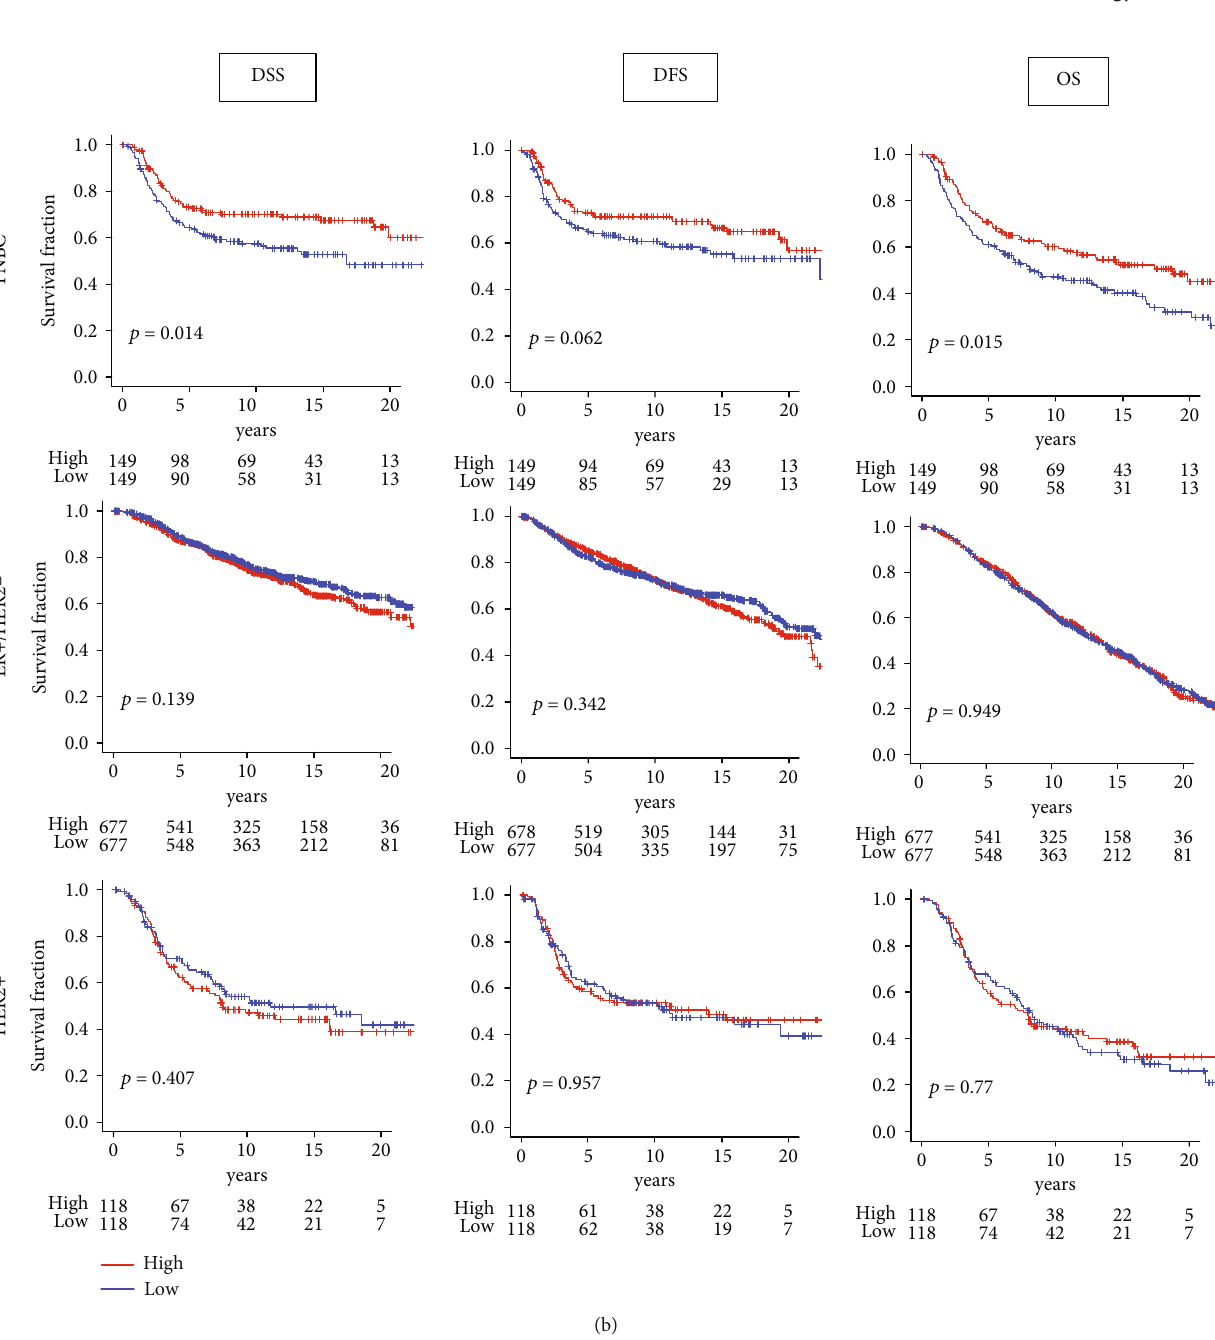
Figure 2: Association between the in fl ammatory pathway score and tumor aggressiveness by the subtypes. (a) Boxplots of the in fl ammatory scores by Nottingham pathological grade in triple-negative breast cancer (TNBC), estrogen receptor-positive/human epidermal growth factor receptor 2-negative (ER+/HER2-), and HER2-positive subtypes of the METABRIC and TCGA breast cancer cohorts. Tukey-type boxplots show median and interquartile level values, and the ANOVA test was used to calculate p values. (b) Tumors with low (blue) and high (red) in fl ammatory scores in both cohorts of patients with each subgroup are compared for survival DSS, DFS, and OS of in fl ammatory score high and low in fl ammatory groups in each breast cancer subtype of METABRIC cohort. Log-rank test used to calculate p values to compare two groups with Kaplan-Meier survival